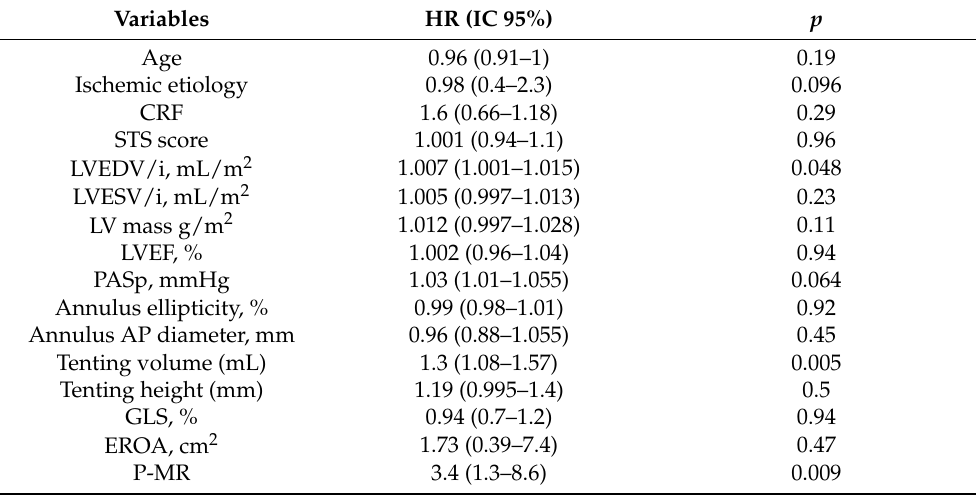
Table 2. Determinants of CV death/ HF rehospitalization within 1 year. Univariate analysis. Variables